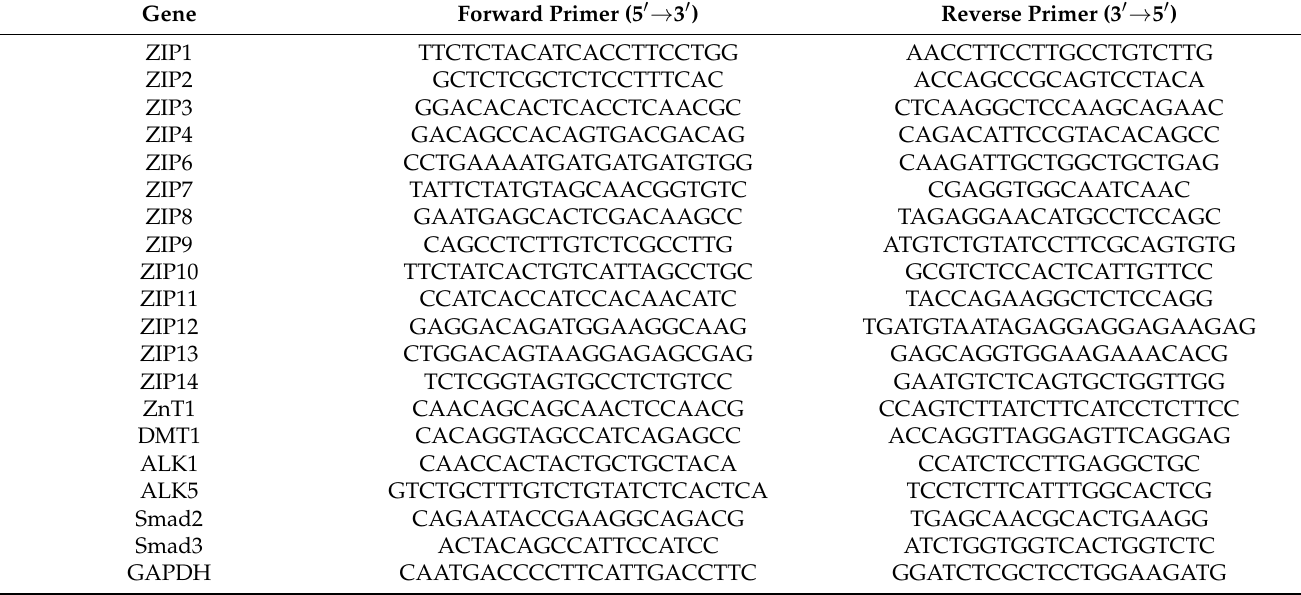
Table 1. Primers for real-time RT-PCR used in this